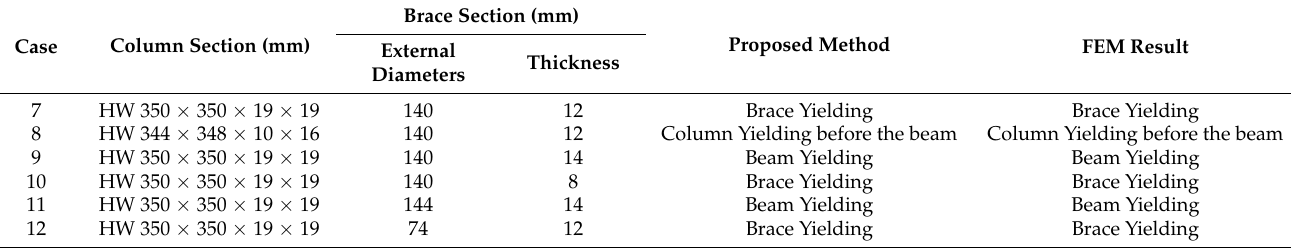
Table 5. Finite element verification results (typical floor, η = 0).